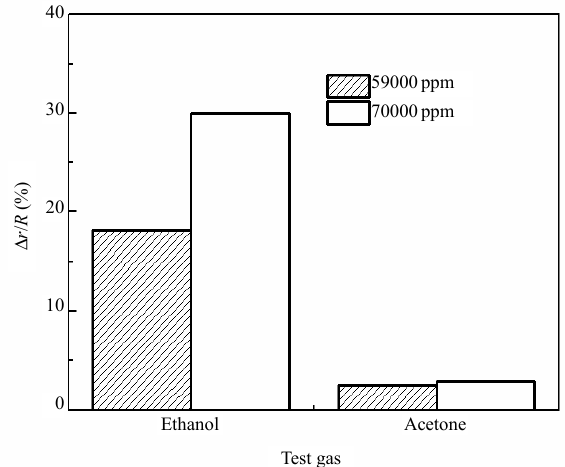
Fig. 7 Response of the coupling sample for different